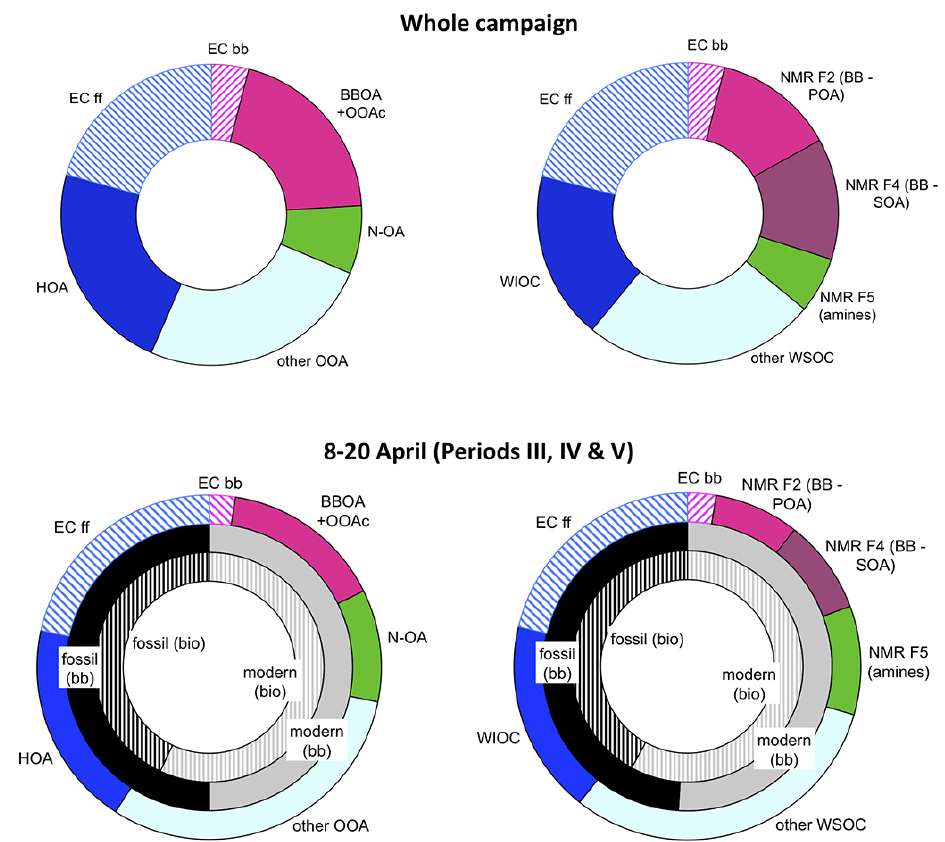
Figure 10. Carbon budget of aerosol TC for the whole campaign (upper two panels) and for the period covered by the isotopic analyses (lower panels). Budgets are reconstructed based on PMF-AMS components (left) and NMR factors for WSOC (right). For more explanations refer to the